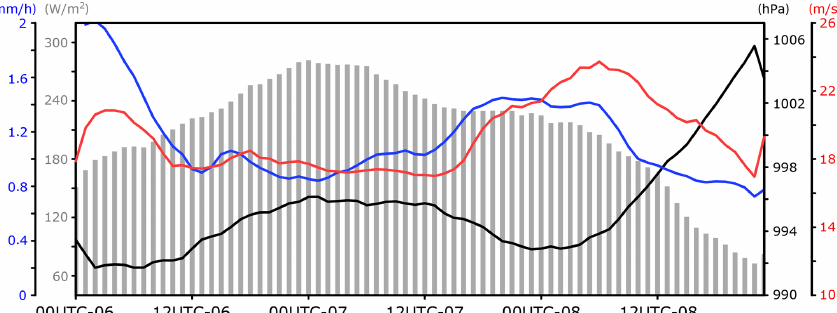
Figure 4. Time series of sea level pressure (SLP) at grid of cyclone centre (black line), latent heat flux (grey bar), and precipitation (blue line), and averaged wind speed exceeding the 95th percentile (red line) within the 250km radius of the simulated medicane averaged within a radius of 250km. Note that the TD_W6_MJ (orange) terminates at 23:00–08:00UTC due to the extinction of the simulated medicane, and the values of TD_W6_MJ are excluded from the ensemble mean at